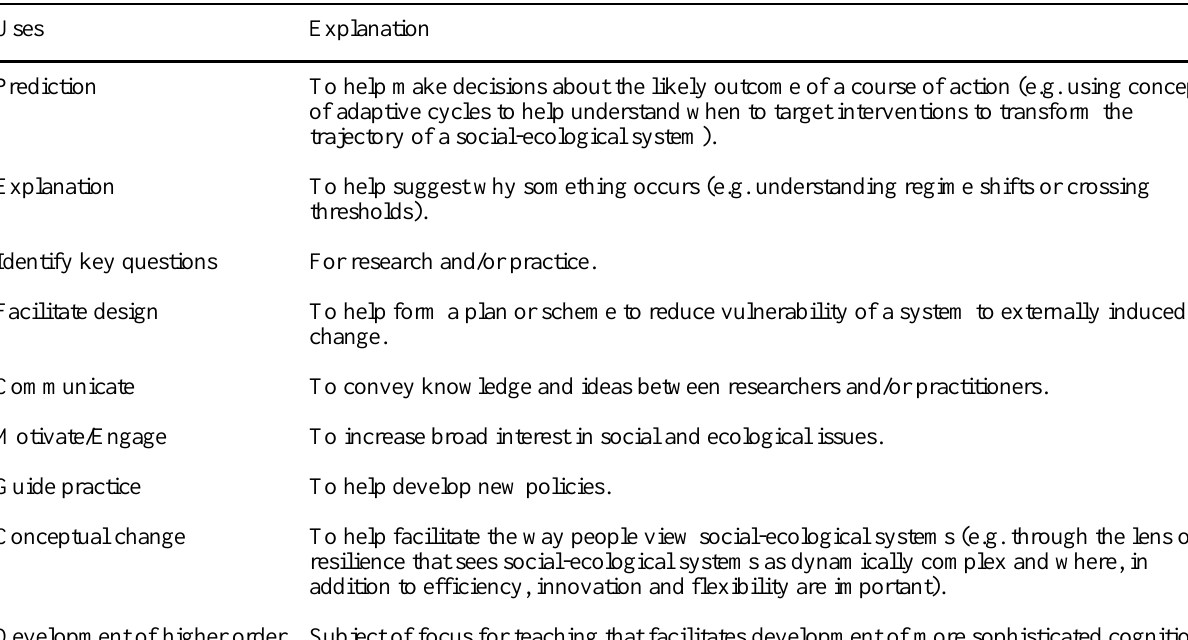
Table 1 . Possible uses of Resilience Thinking as a framework of inter-related concepts (modified from Fazey